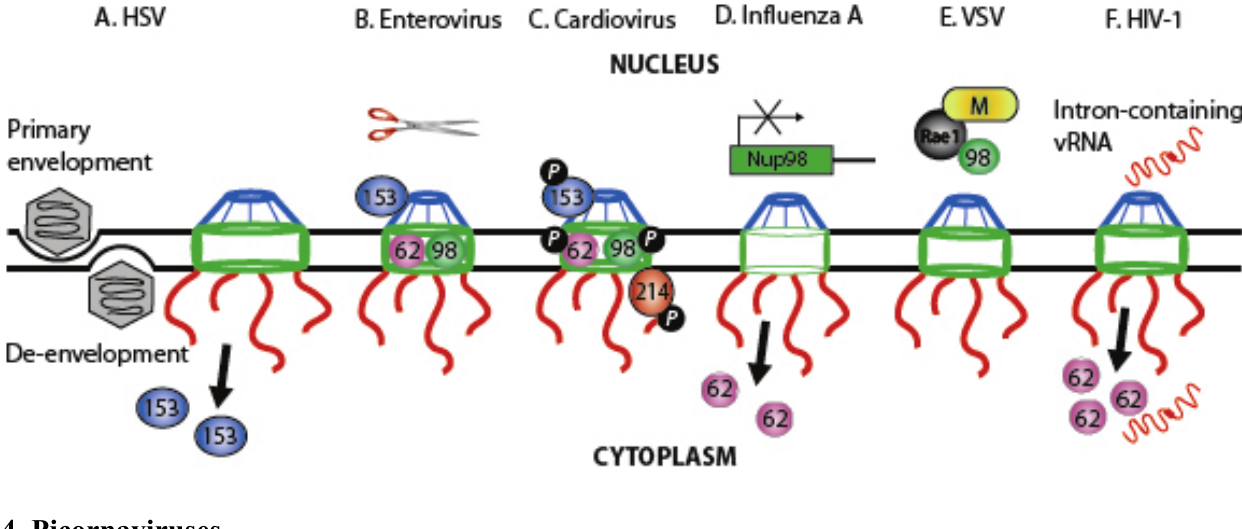
Figure 3. Changes to the NPC by viruses during nuclear export. Schematic representations of the different mechanisms by which 6 viruses subvert various Nups in order to facilitate nuclear export. ( A ) HSV-1 capsids exit the nucleus via a process of primary envelopment and de-envelopment. Secondary effects include dilation of the NPC channel and redistribution of Nup153. ( B ) Enteroviruses replicate in the cytoplasm and induce degradation of Nup62, Nup98 and Nup153 by the protease 2A pro (scissors). ( C ) Cardiovirus infection induces hyperphosphorylation ( P ) of Nup62, Nup98, Nup153 and Nup214. ( D ) Influenza A downregulates the expression of Nup98 and relocalizes Nup62 to the cytoplasm. ( E ) VSV M protein inhibits mRNA export through an interaction with the Rae1-Nup98 complex in the nucleoplasm. ( F ) HIV-1 Rev-mediated vRNA export is CRM1-dependent and causes the displacement of Nup62 into the